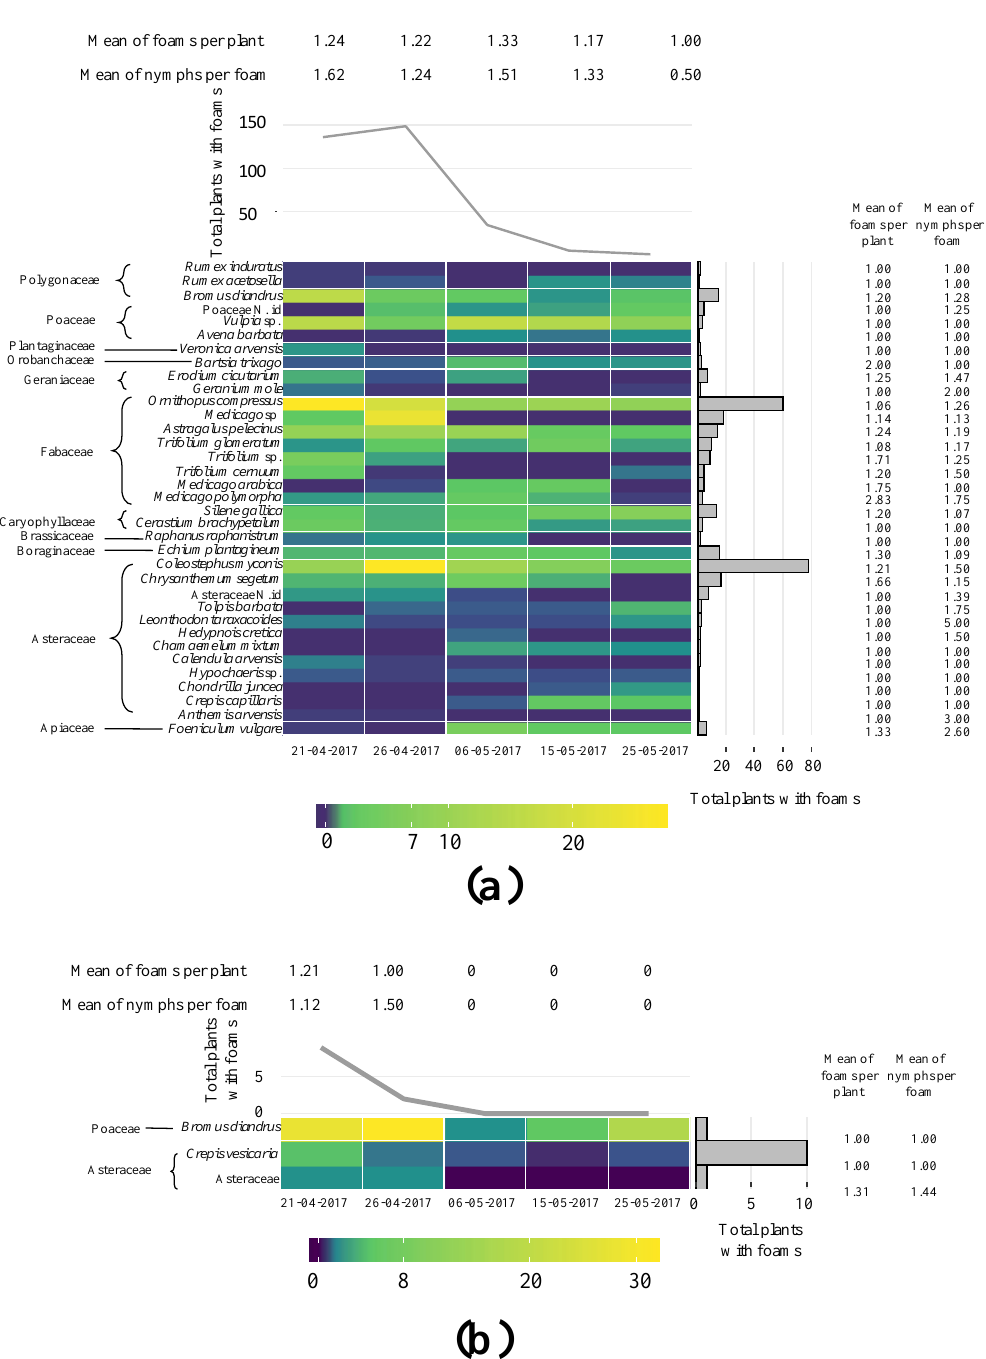
Figure 1. Heatmap plot showing 2017 data: ( i ) the percentage of plants with foam of all plants within a taxon (dark purple to yellow) (only host plants shown); ( ii ) total plants with foams during the collection period (top line graph); ( iii ) total plants with Aphrophoridae foams in the identified plants (right bar graph); ( iv ) mean of Aphrophoridae foams per infested plant and date; ( v ) mean of Aphrophoridae nymphs per foam per plant and date. ( a ) Integrated olive orchard burned in 2016 (UNP). ( b ) Productive integrated olive orchard (P). N. id. after taxa means not identified specimens belonging to that group. Families are indicated at the left of the plant species.